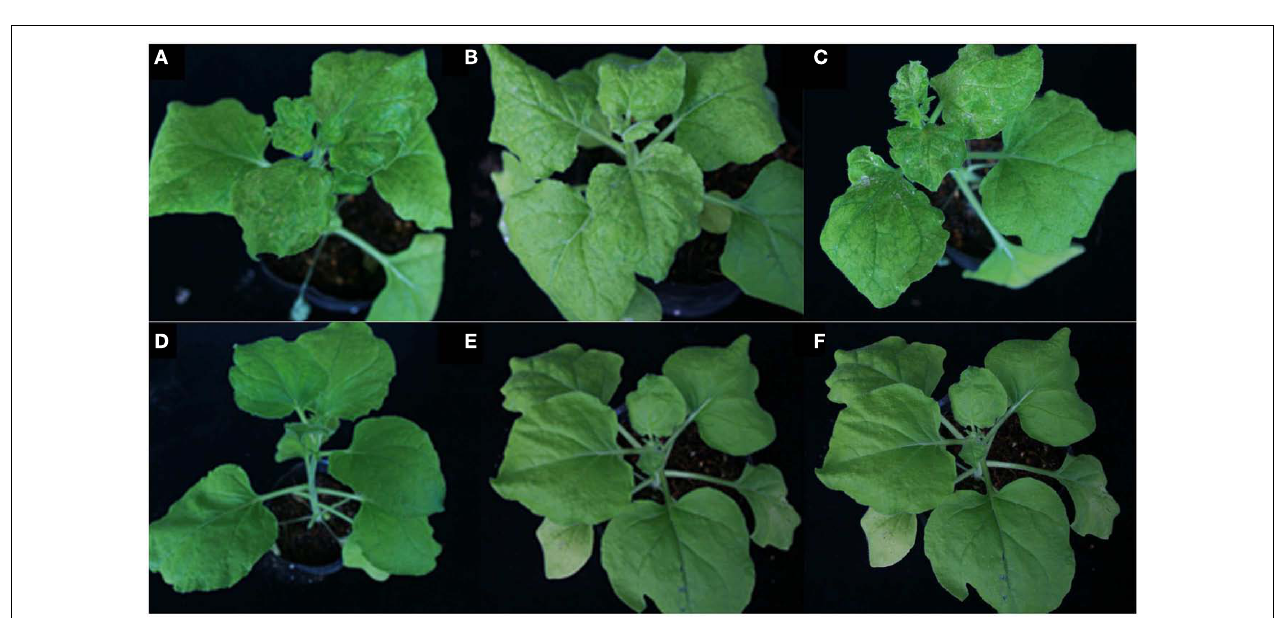
FIGURE 10 | Symptoms elicited by wild type PVX or PVX expressing mutants of NSvc4. N. benthamiana plants were agroinfiltrated with various PVX constructs. Plant infected with PVX-NSvc4 (A) , PVX-NSvc4 1–125 (B) , PVX-NSvc4 125–286 (C) , PVX (D) , PVX-NSvc4 1–53 (E) , and PVX-NSvc4 1–73 (F) . Photographs were taken at 20days post